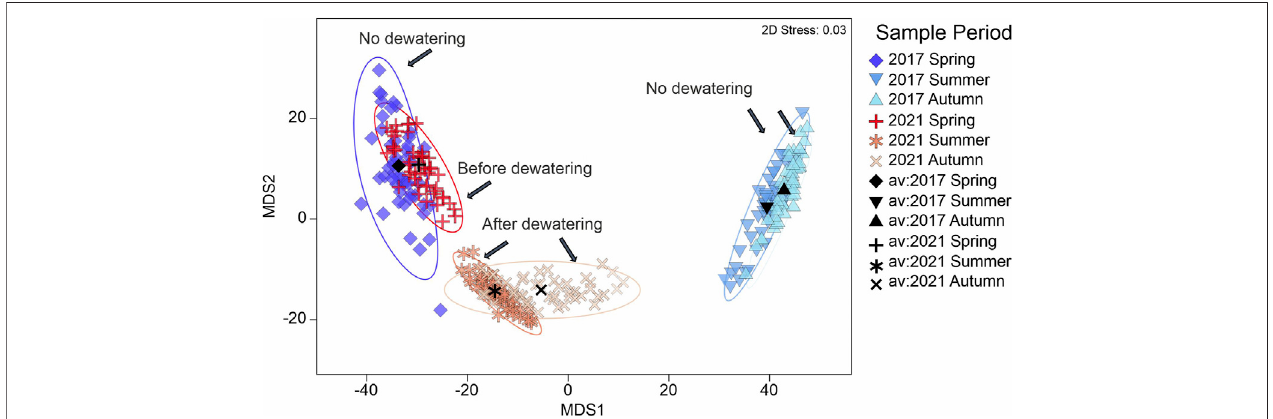
FIGURE 6 | Metric multidimensional scaling (MDS) of bootstrap averages of the fi sh community composition in 2017 and 2021 before and after the dewatering event.BootstrapaveragesarebasedonthepairwiseBray – Curtissimilaritiesbetweenthe fi shcommunitycompositionofeachsamplingevent.Shadedellipsesrepresent more than 95% of all bootstrap average points of each site, av =